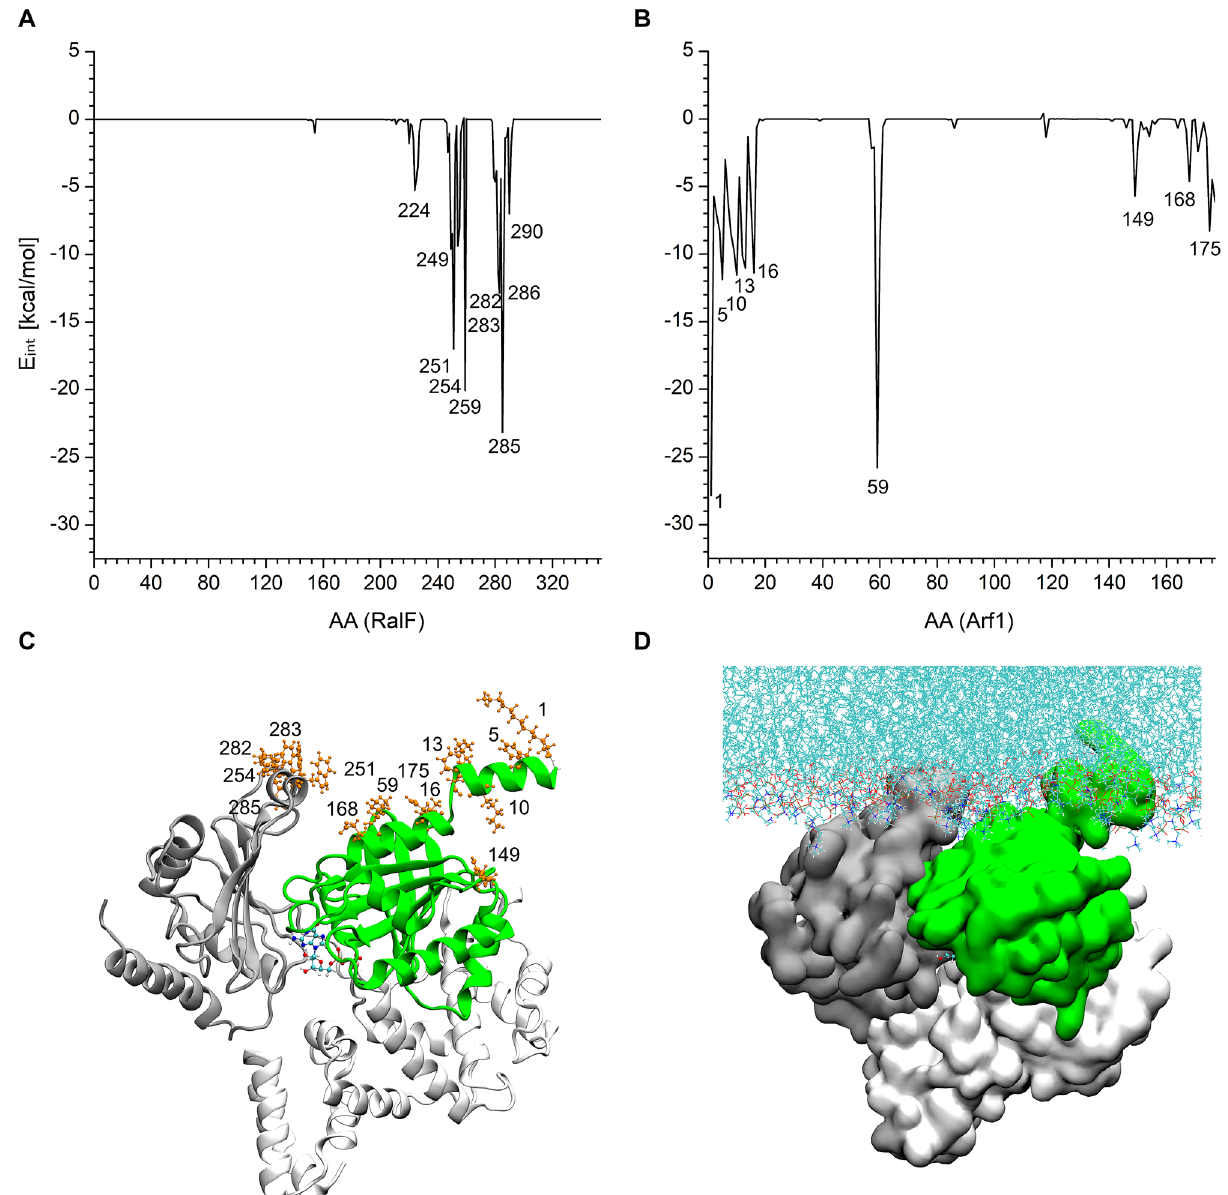
Figure 6. Interaction energy of the residues of ( A ) RalF and ( B ) Arf1 with the membrane. 3D structure of the RalF-Arf1 complex in ( C ) cartoon and ( D ) surface representation. The most interacting residues are represented in orange CPK. The RalF Sec7 is shown in white, the Capping domain in grey, and the Arf1 in bond; K249 RalF /D164 Arf1 and K323 RalF /E41 Arf1 of switch1 forming a salt bridge interaction which are represented on Fig. 5C. As part A of the figure shows, the RalF Linker region (residues 192–200, denoted by light violet) also plays